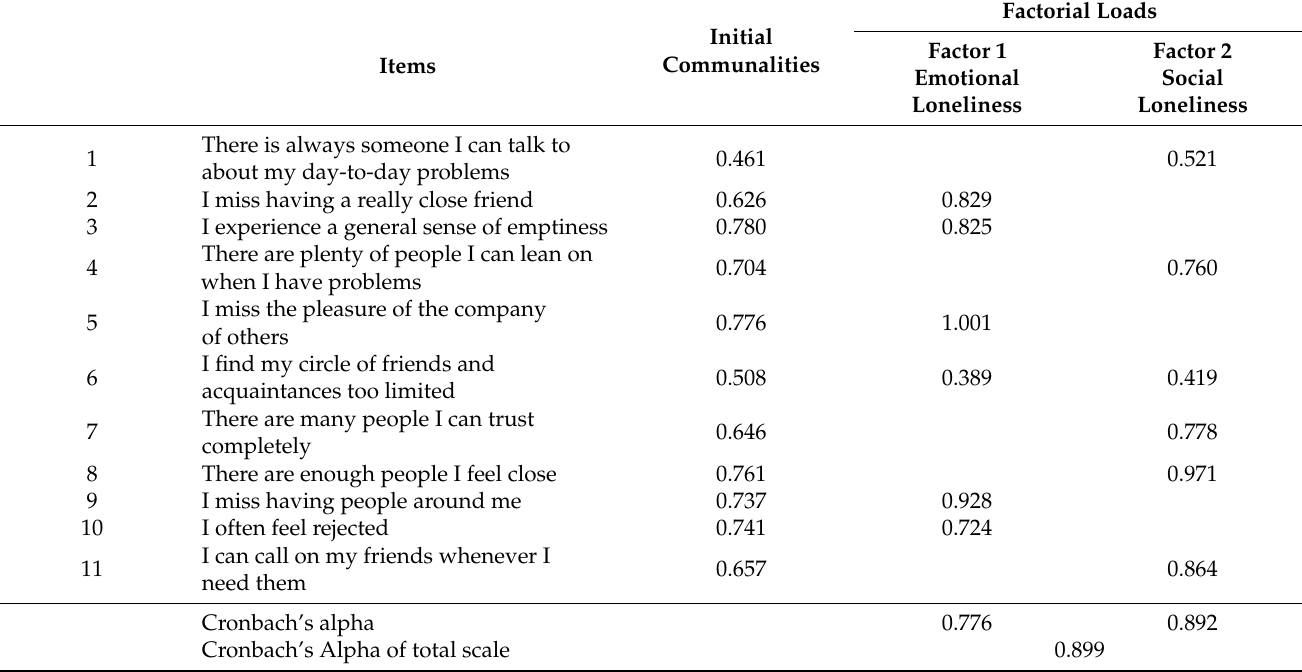
Table 4. Factor structure and factorial loads of the items in the two-factor